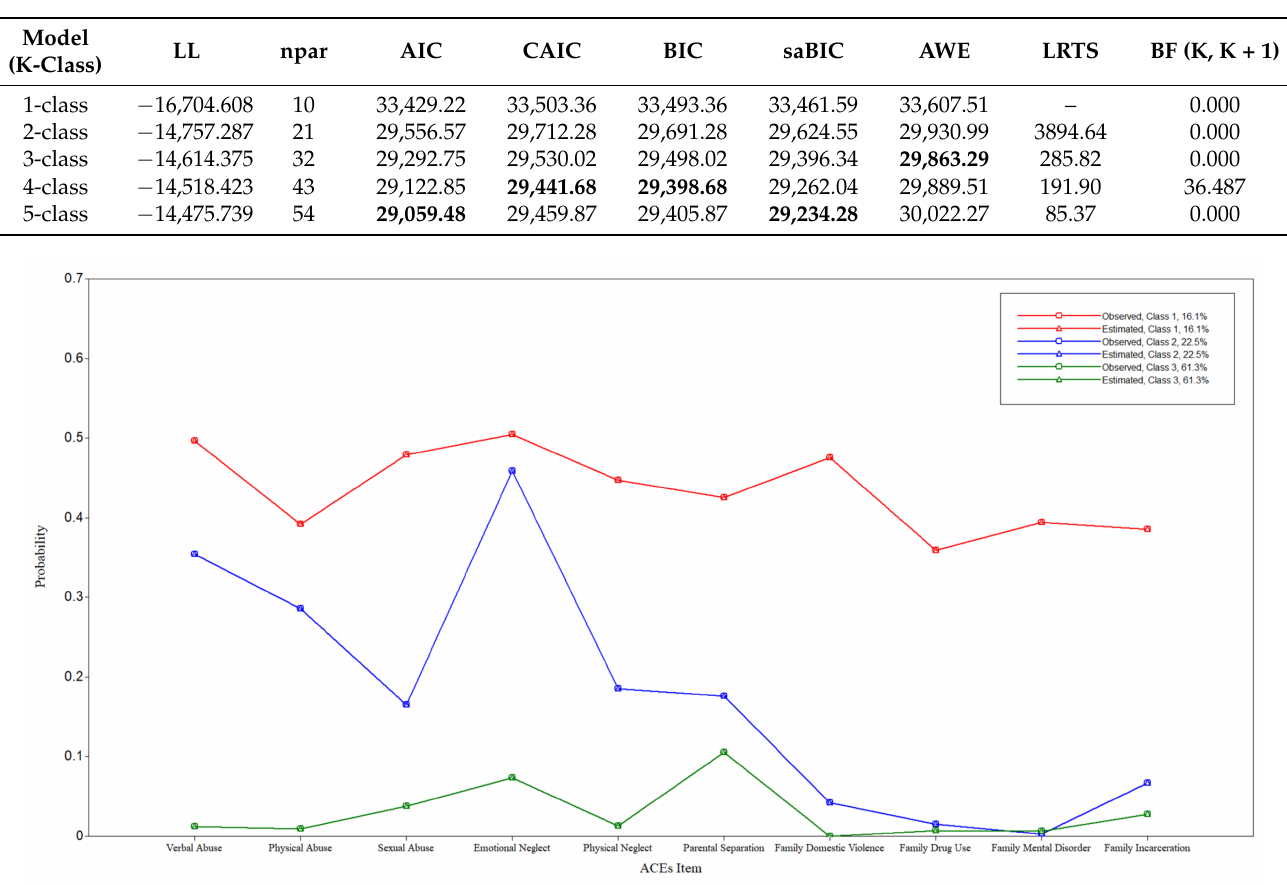
Table 2. Fit indices of LCA Class Models.